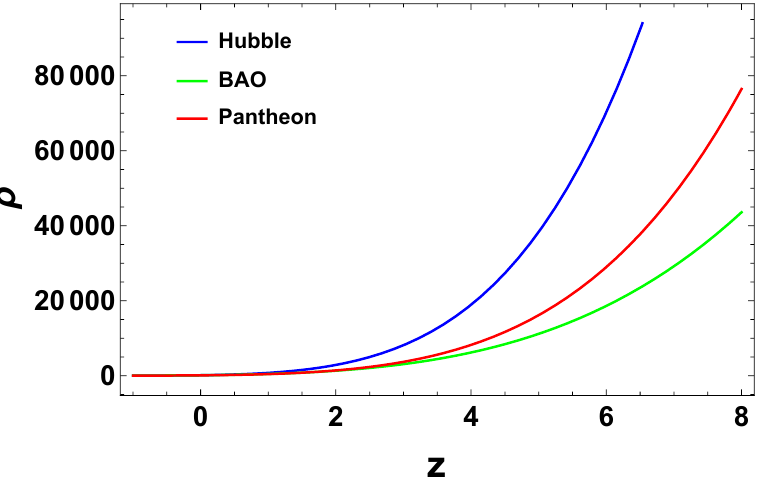
Figure 6. Profile of the density parameter for the given model corresponding to the values of the parameters constrained by the Hubble, BAO, and Pantheon data point